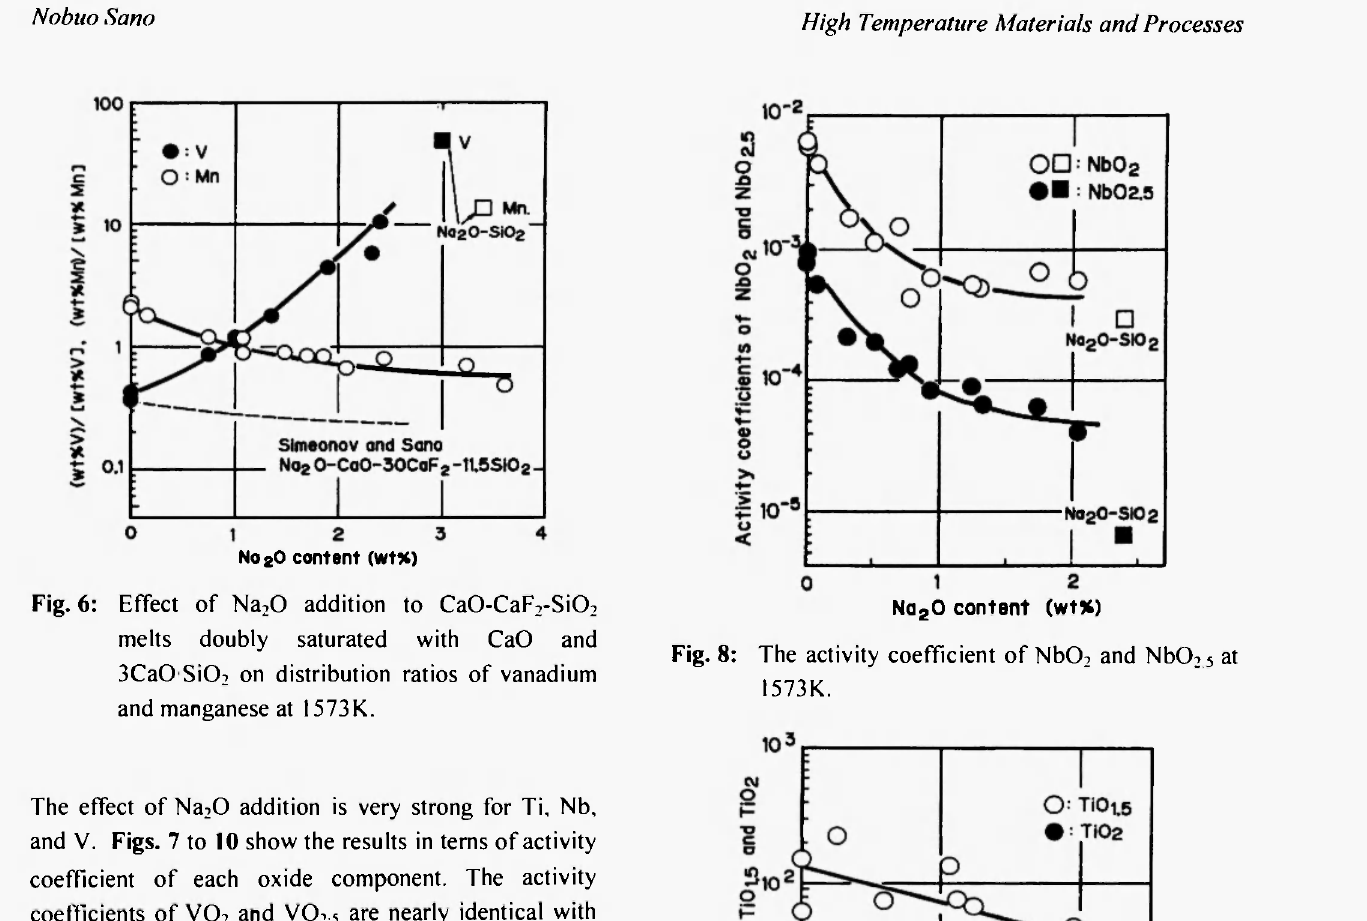
Fig. 8: The activity coefficient of Nb0 2 and Nb0 2 5 at 1573K.